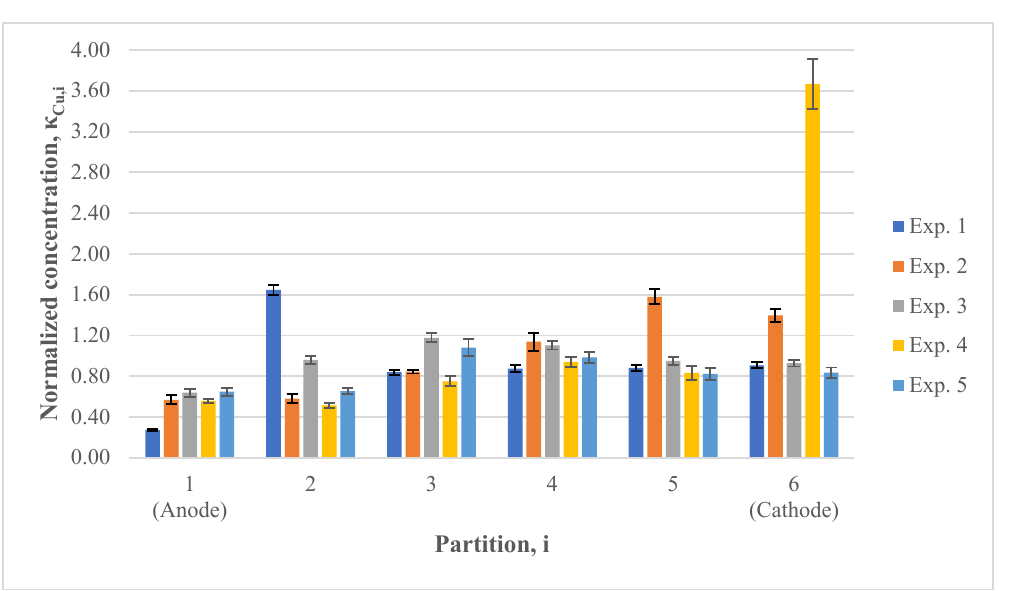
Figure 3. Total copper concentration.